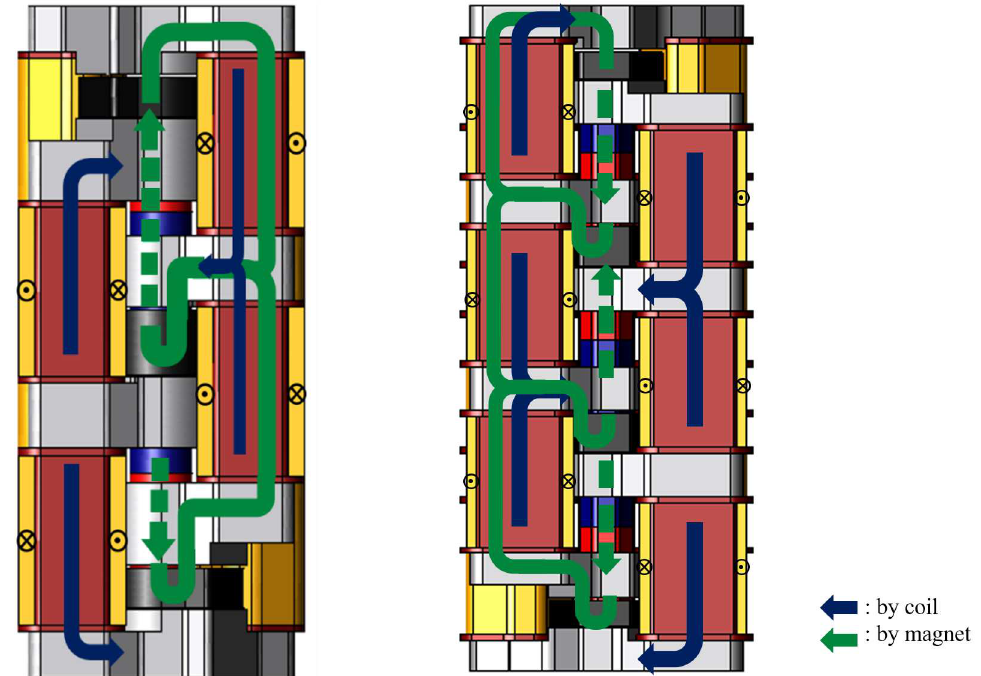
Figure 5. Structure of the conventional model and proposed model.